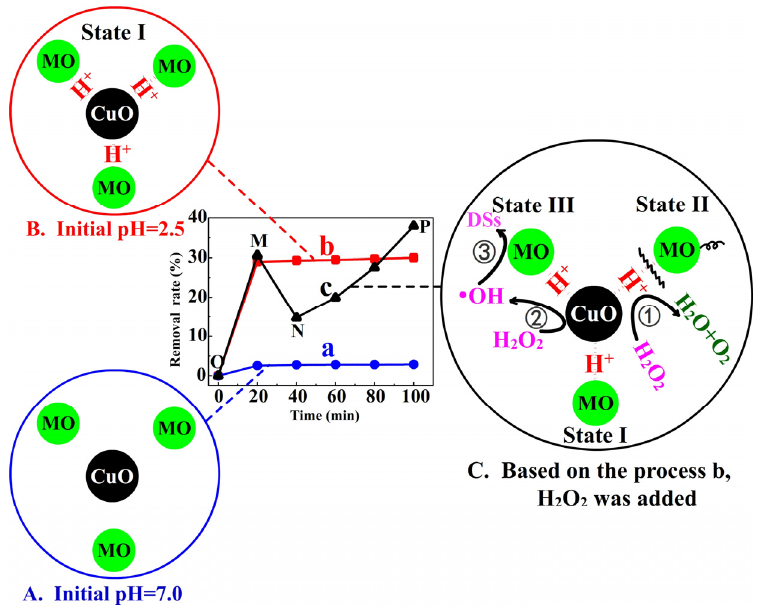
Figure 6. The state-changing schematic diagram of MO molecules on the catalyst surface in MO + CuO + H 2 O 2 system. ( A ) CuO + neutral MO solution. ( B ) CuO + MO solution (pH = 2.5). ( C ) When CuO + MO solution (pH = 2.5) reached adsorption–desorption equilibrium, H 2 O 2 was added. (MO: 10 mg/L, 50 mL; CuO: 20 mg; H 2 O 2 : 5%, 1 mL).